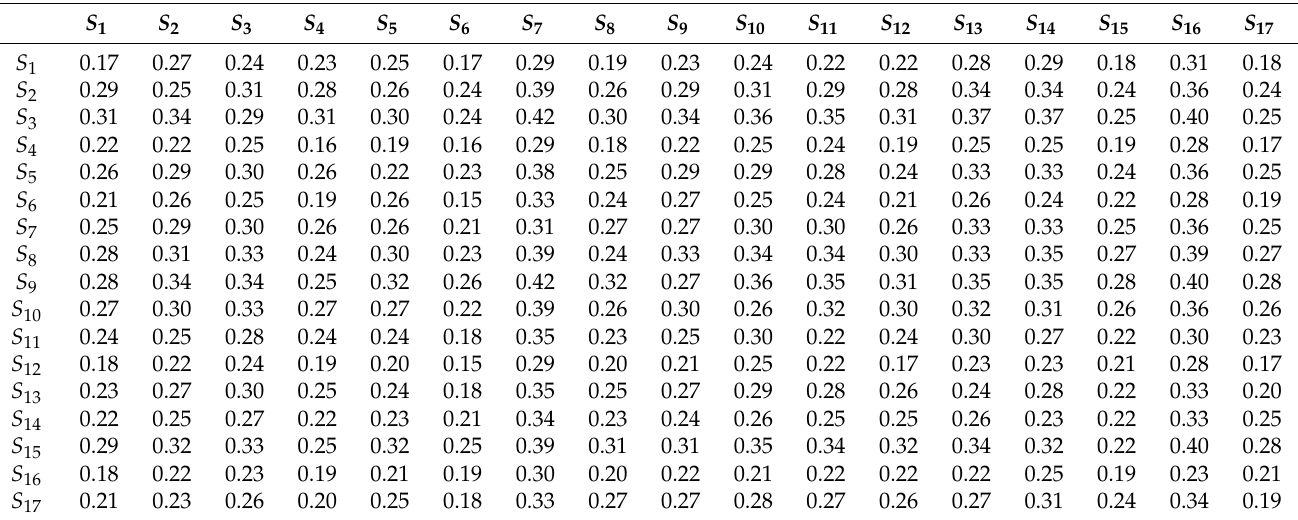
Table 8. Comprehensive influence matrix T